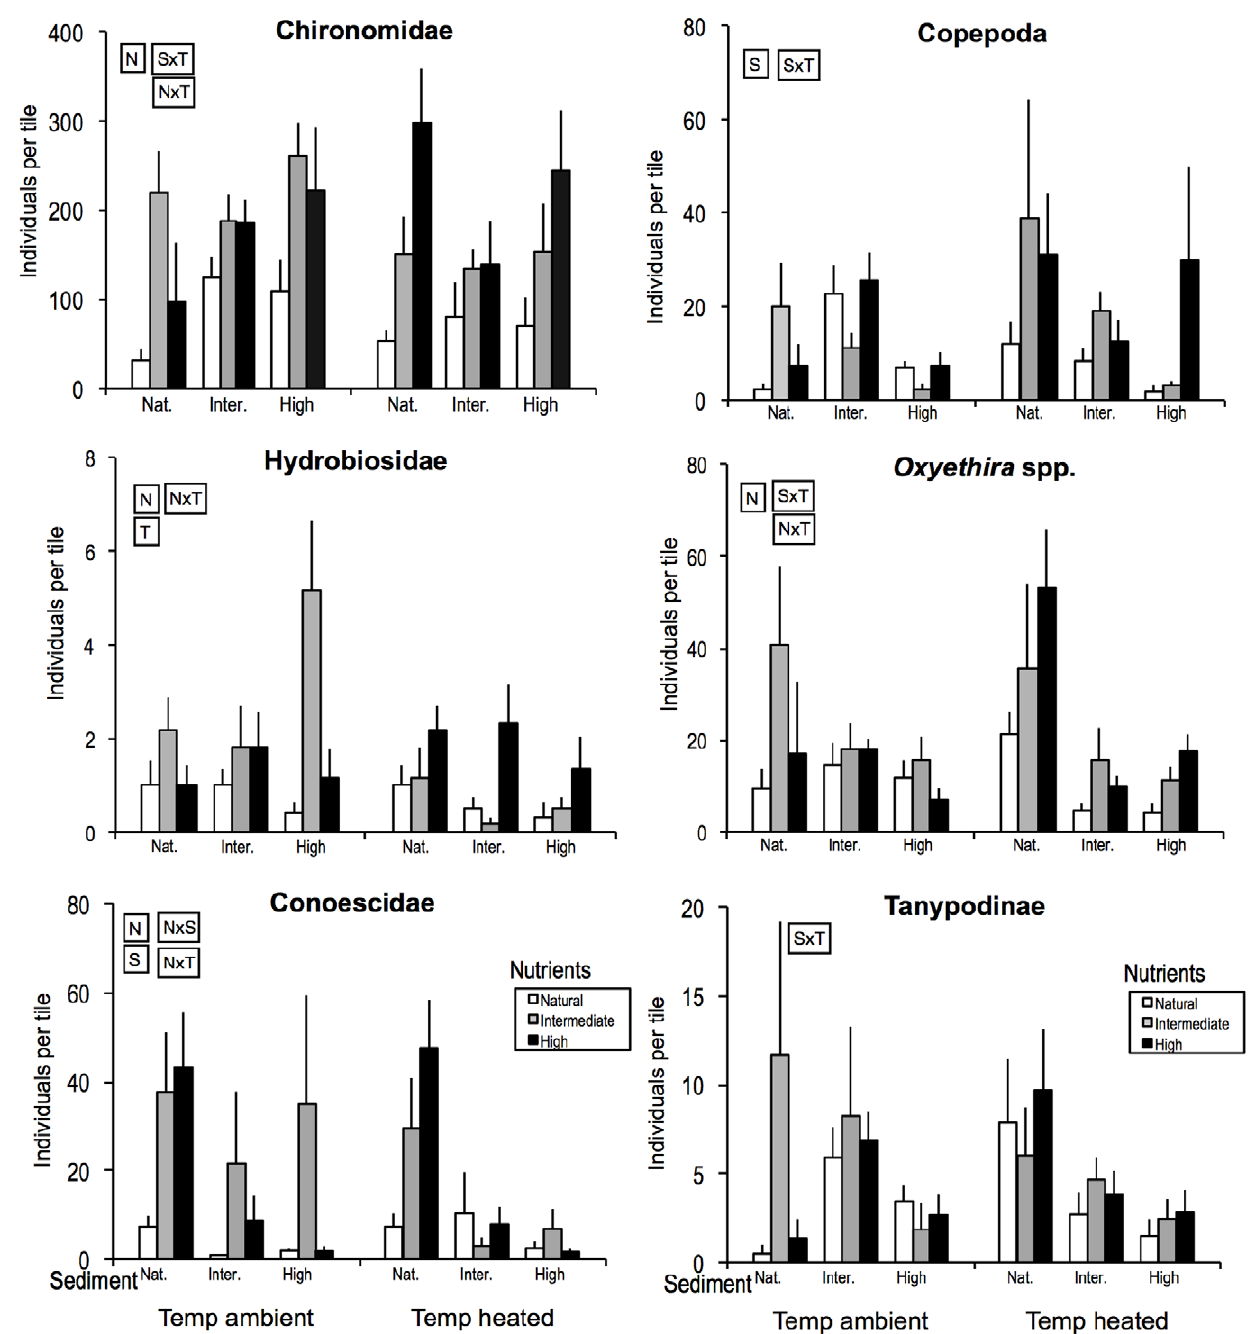
Figure 2. Abundance patterns (averages + SEs) for common invertebrate taxa (days 18 and 30 combined) that showed significant interactions between paired manipulated factors. For more details see Fig. 1.